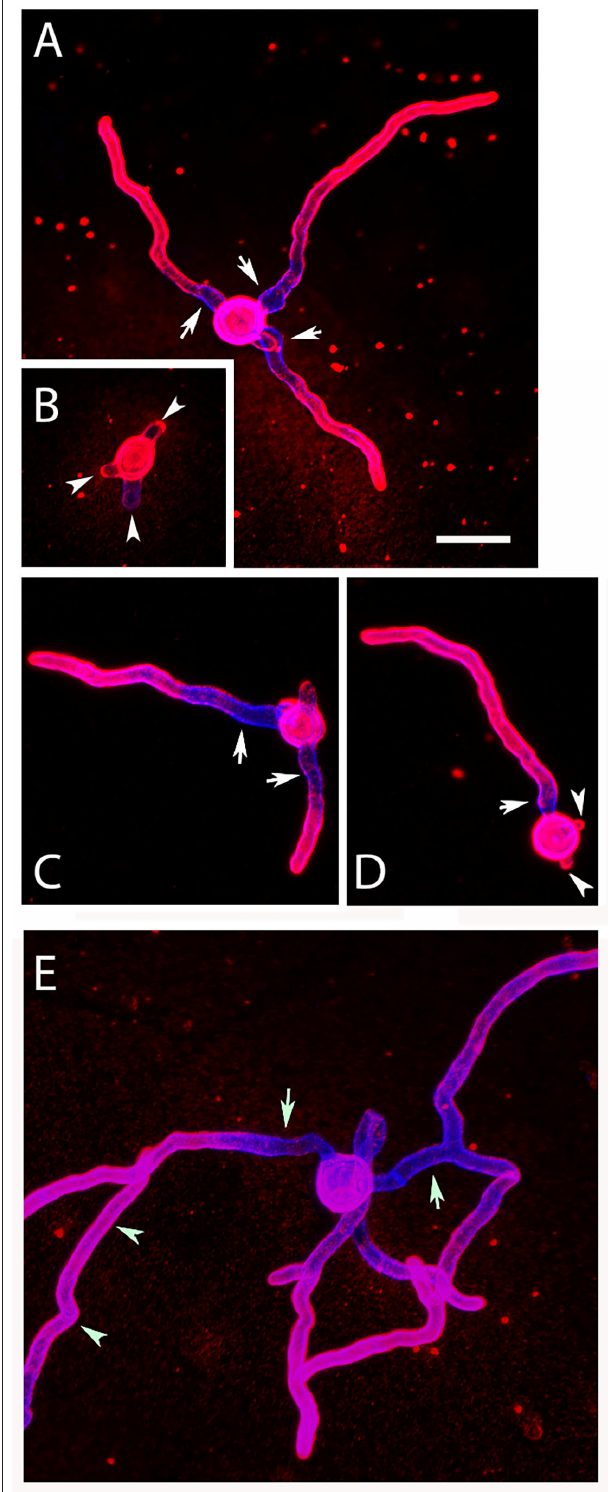
FIGURE 5 | Germination of AC: morphology and distribution of galactomannan. Purified AC were cultivated at 37 ◦ C in AMM, fixed after 6 and 9h, and stained with Calcofluor white (blue) and the galactomannan-specific